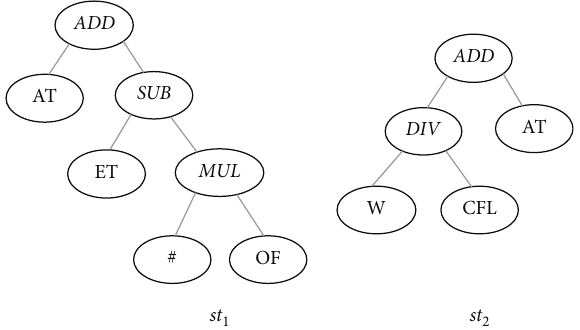
Figure 2: Example of two subtrees. (a) st